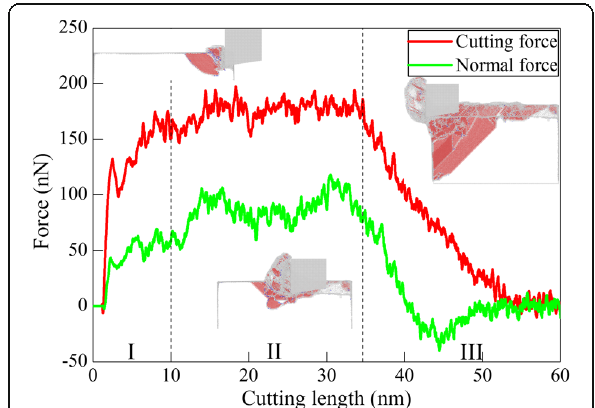
Fig. 3 Variation of machining force; (color online) variation of cutting force and normal force with cutting length during the diamond cutting of Ce(010) under a rake angle of 0°. Subfigures present representative defect configurations in different zones, in which atoms are colored according their CNA